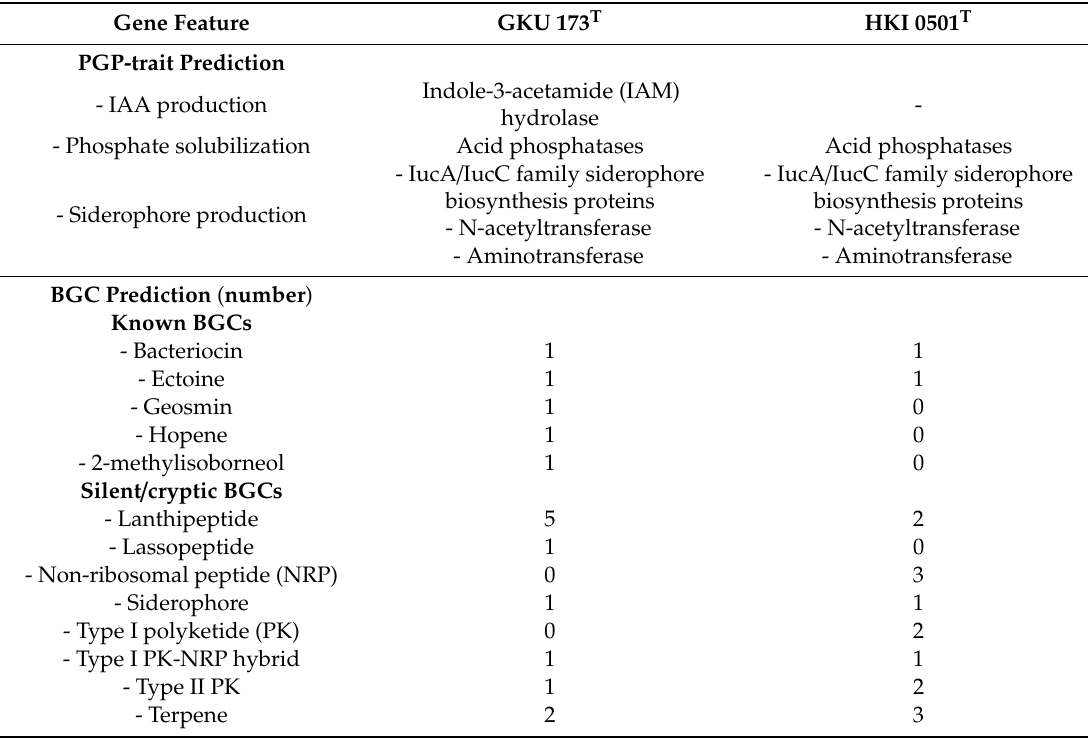
Table 2. Genome analysis of PGP-trait and biosynthetic gene cluster (BGC) prediction of strain GKU173 T and Fodinicola feengrottensis HKI 0501